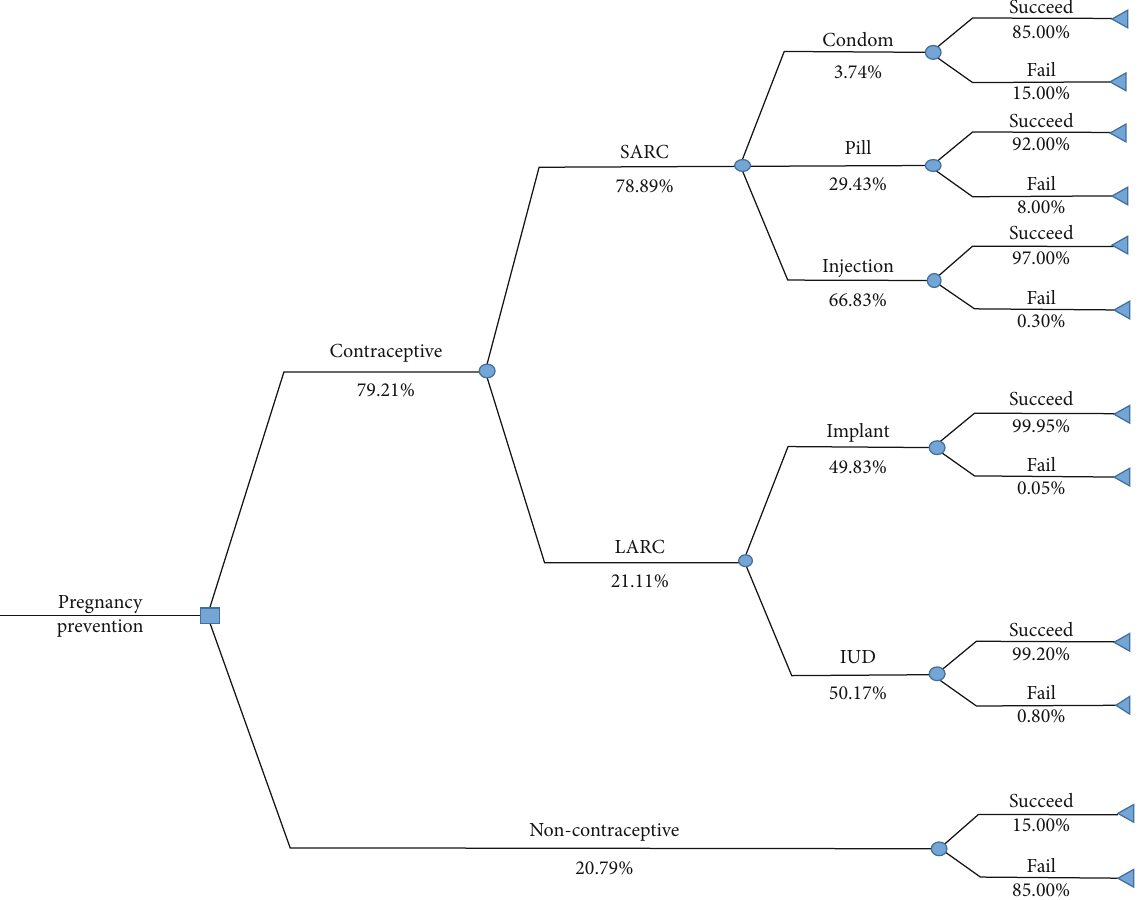
Figure 1: Decision tree